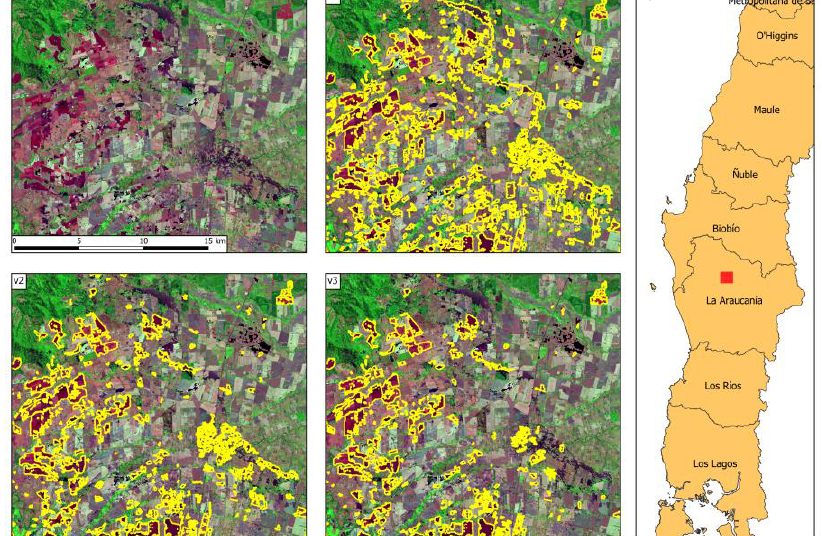
Figure 2. Comparison of different versions of the BA product in a sample area located in the Araucanía Region.